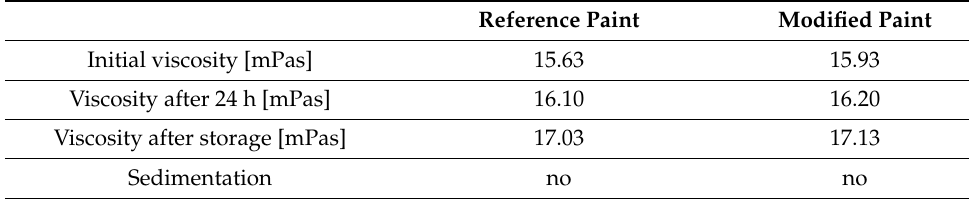
Table 4. Viscosity measurements and storage stability.